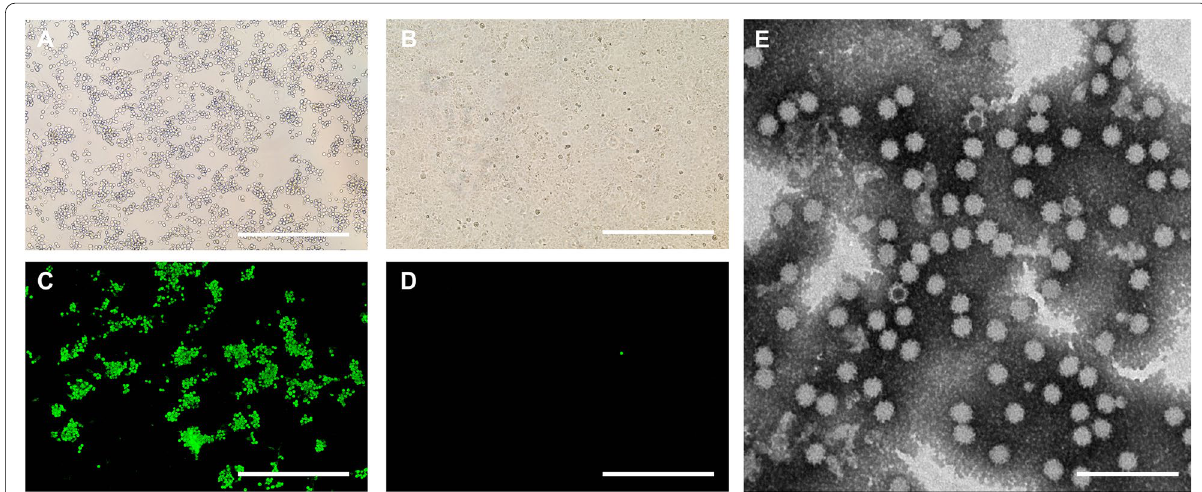
Fig. 1 Isolation and identification of feline calicivirus (FCV). A Cytopathic effect (CPE) of F81 cells at 24 h post infection (hpi) with FCV HB7 isolates under microscope (200 ). The scale bar is 60 μm. B CPE of uninfected cells (negative controls) under microscope (200 ). The scale bar is 60 μm. C × × FCV isolate-specific indirect immunofluorescence analysis (IFA, green fluorescence) of F81 cells at 24 hpi. The scale bar is 60 μm. D CPE of uninfected cells (negative controls) under fluorescence microscope (200 ). The scale bar is 60 μm. E Feline calicivirus (FCV) virion under a transmission electron × microscope. The scale bar is 200